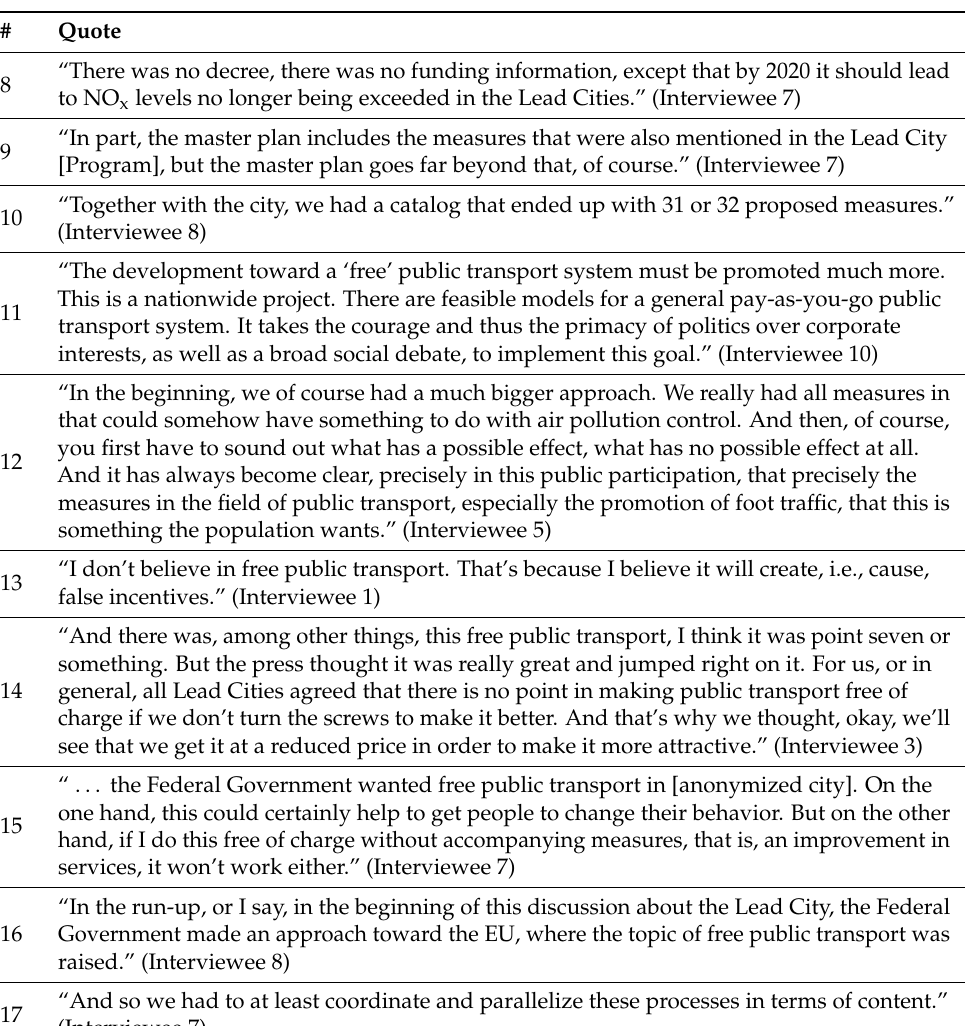
Table 5. Quotes from the interviews outlining the policy stream in the three Lead